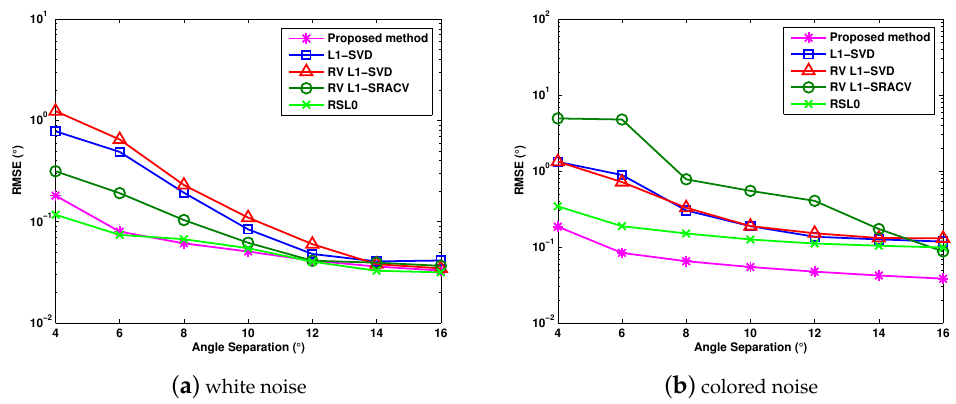
Figure 6. RMSE versus angle separation with SNR = 0 dB.